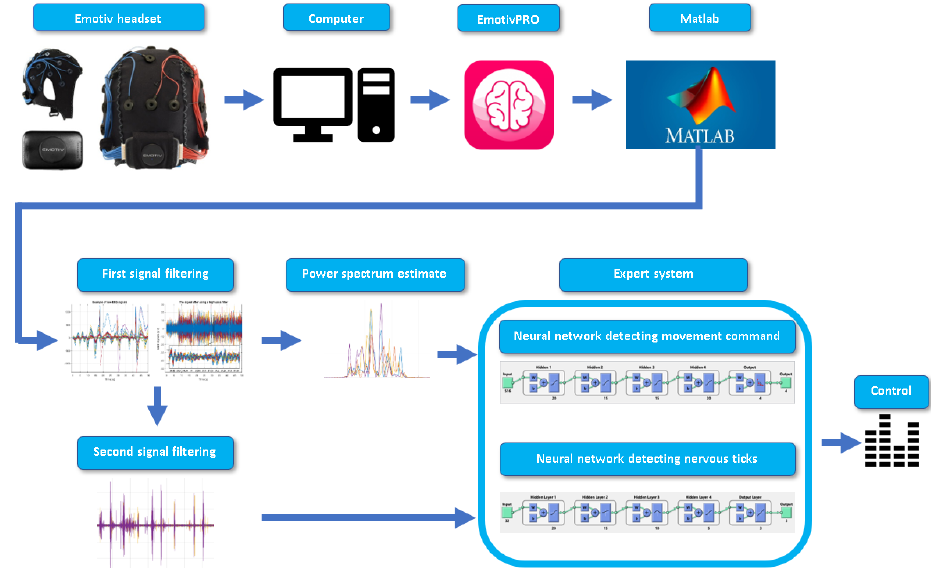
Figure 4. Data acquisition, analysis and classification system.